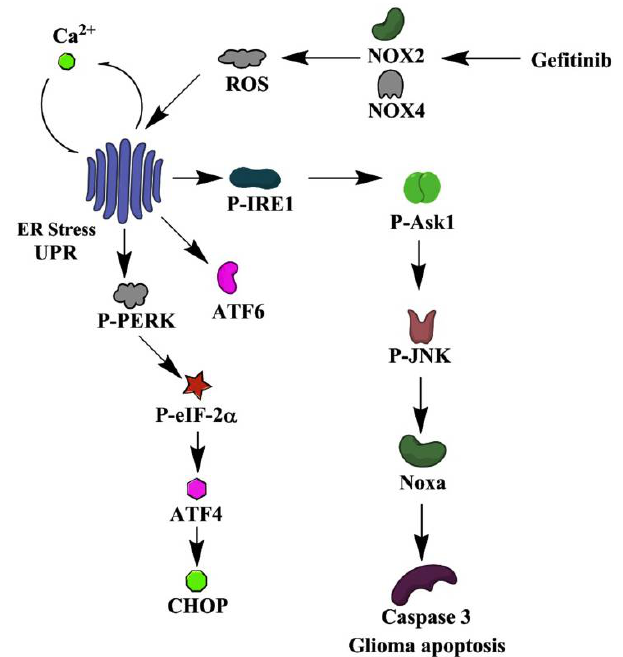
Figure 7. A possible schema of apoptotic mechanism in glioma cells elicited by gefitinib is proposed. The schematic diagram indicates the cellular molecules, signaling molecules, and cascades used in mediating the induction of ER stress/Unfolded Protein Response (UPR) and the consequences of apoptosis after gefitinib treatment in glioma cells. Some additional signaling molecules and cascades were omitted for the sake of clarity.